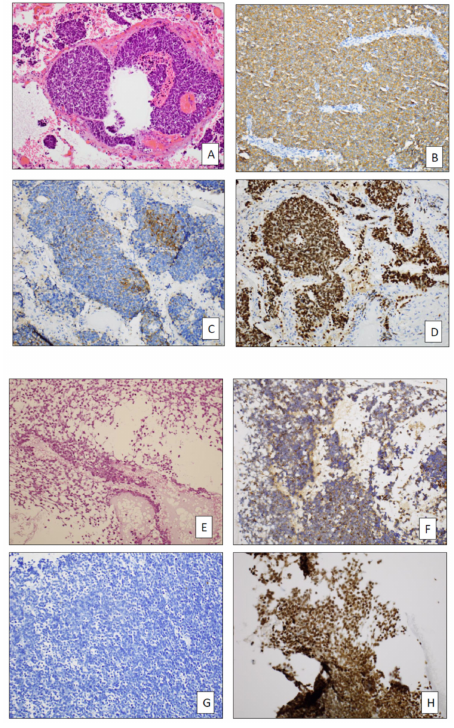
Figure 2. NUT lung carcinoma. Tissue ( A – D ) and cytological ( E – H ) samples from the same patient. ( A – D ) Tissue specimen from a lobectomy. ( A ) Proliferation of a poorly differentiated carcinoma (hematoxylin eosin, magnification × 200). ( B ) Expression of cytokeratins (anti-pancytokeratins anti- body, immunoperoxidase, magnification × 200). ( C ) A rare NUT tumor expressing the chromogranin (anti-chromogranin antibody, immunoperoxidase, magnification × 200). ( D ) Expression of the pro- tein NUT in the nuclei of carcinoma cells (anti-NUT, clone C52B1, immunoperoxidase, magnification × 200). ( E – H ) Bronchial aspirates. ( E ) Numerous poorly differentiated and small and non-cohesive tumor cells (hematoxylin eosin, magnification × 200). ( F ) Weak staining with anti-pancytokeratin antibody (immunoperoxidase, magnification × 200). ( G ) Absence of TTF1 expression in tumor cells (anti-TTF1 antibody, immunoperoxidase, magnification × 200). ( H ) Strong expression of the protein NUT in tumor cell nuclei (anti-NUT, clone C52B1, immunoperoxidase, magnification ×